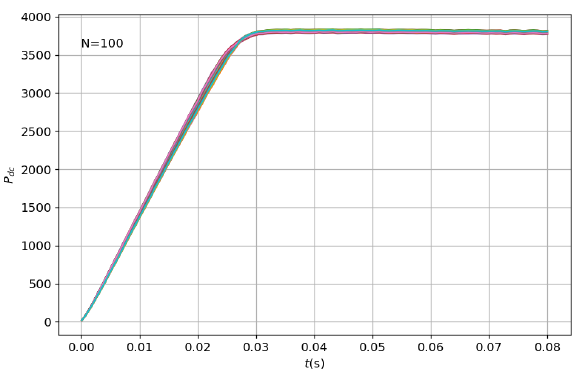
Figure 10. Relationship between the dark corrected pixel values P dc of the red band and the exposure times t .